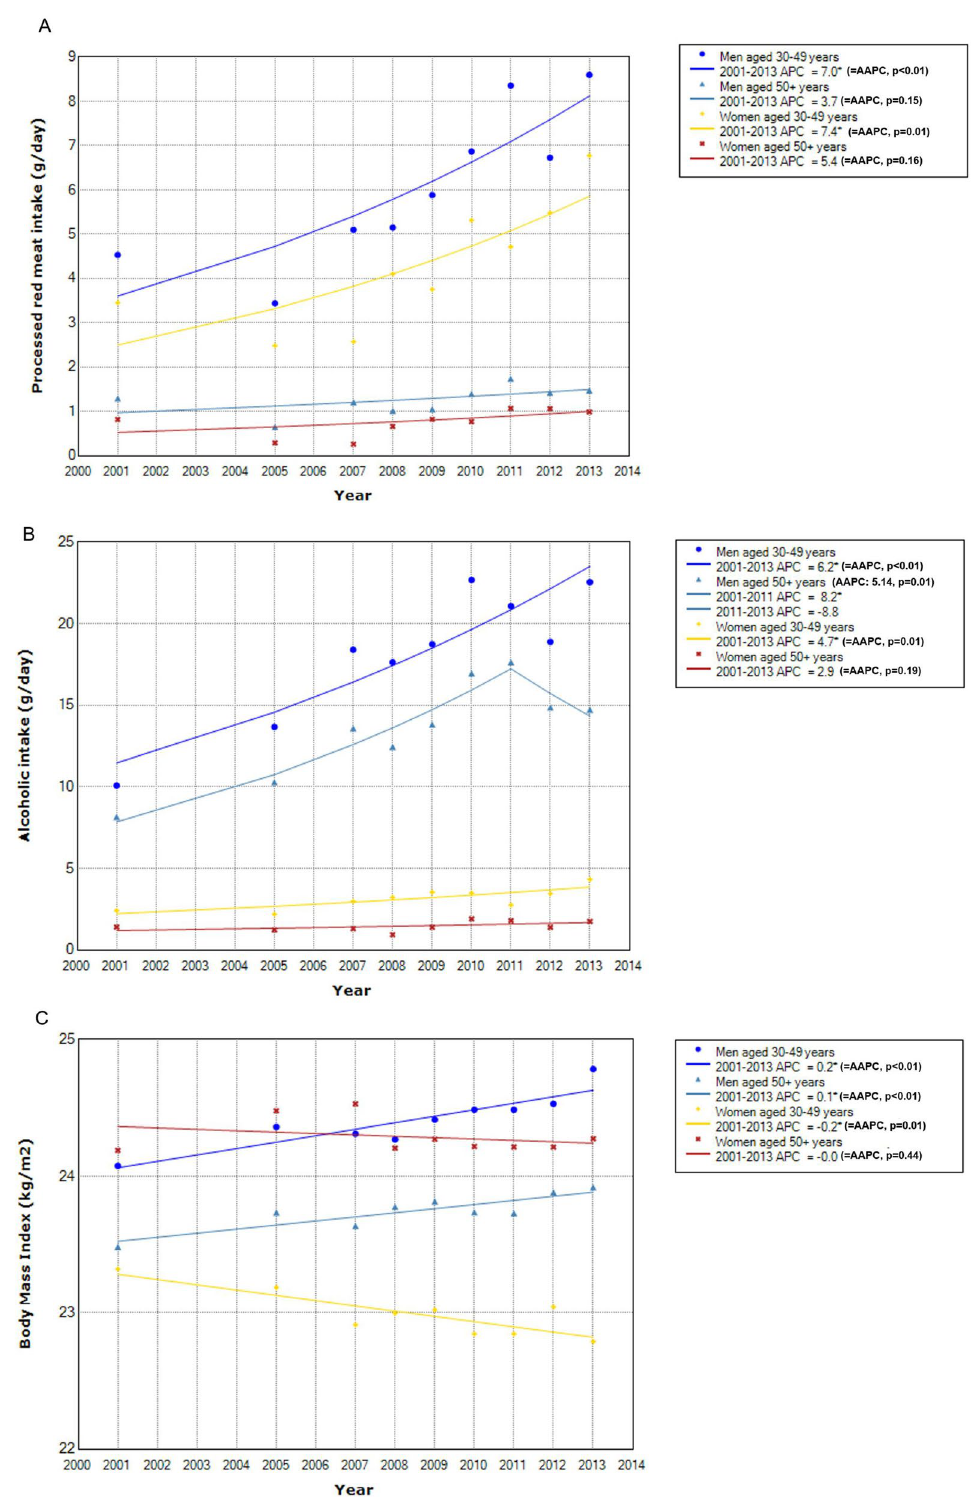
Figure 5. Time trend of distribution of risk factors by sex and age. *Indicates that APC is significantly different from zero at the alpha = 0.05 level. ( A ) Processed red meat intake. ( B ) Alcoholic intake. ( C ) Body Mass Index. ( D ) Waist circumference. ( E ) Red meat intake. ( F ) Current